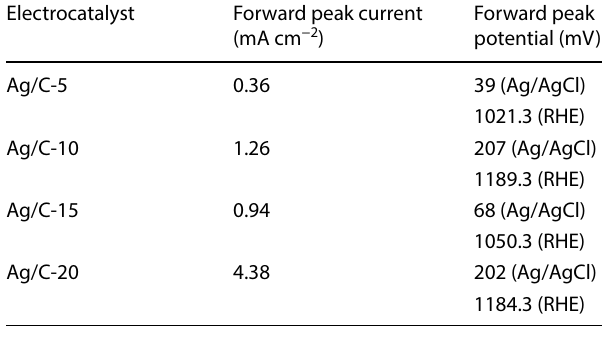
at 100 mV.s −1 4